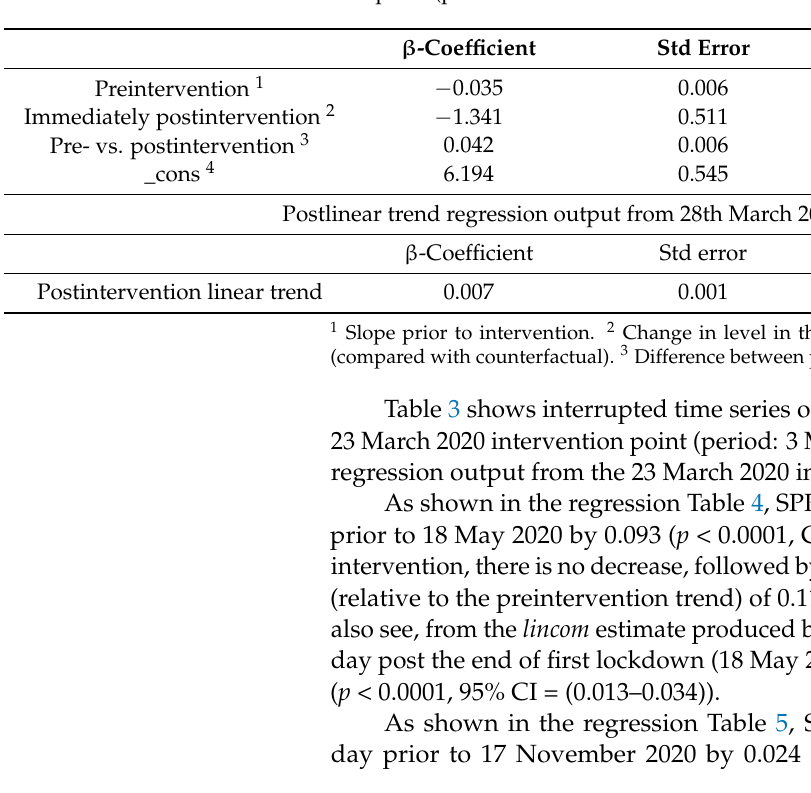
Table 6. Interrupted time series ordinary least-squares regression output at 28 March 2021